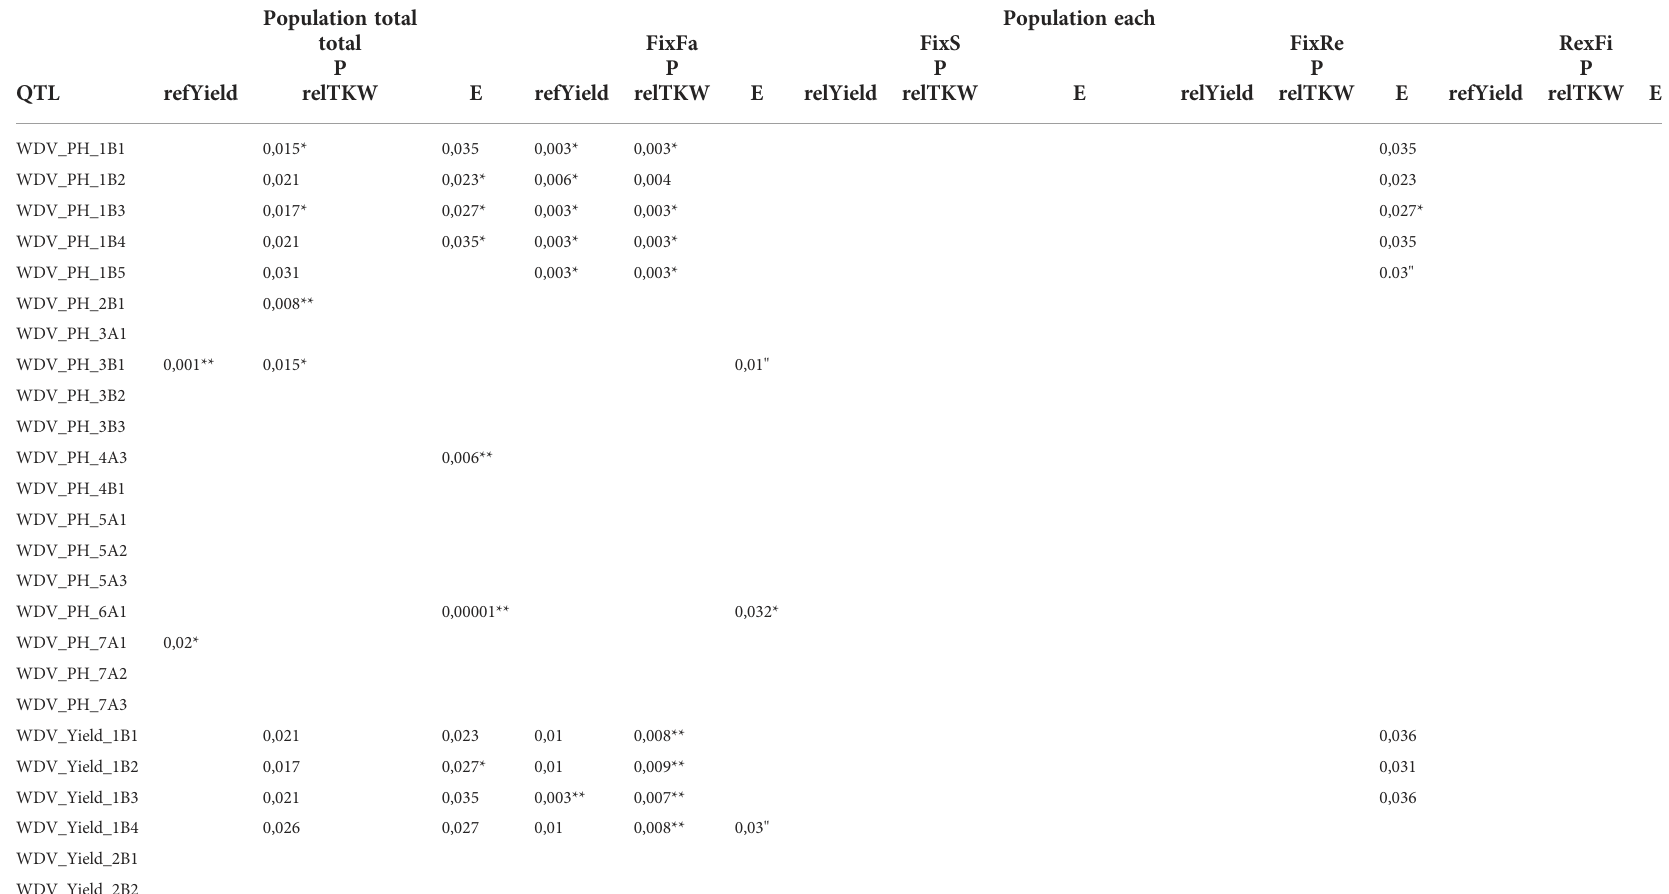
TABLE 4 Validations of the identi fi ed QTL using a t-Test, *, ** indicate signi fi cant differences between allele means at 5% and 1% level,